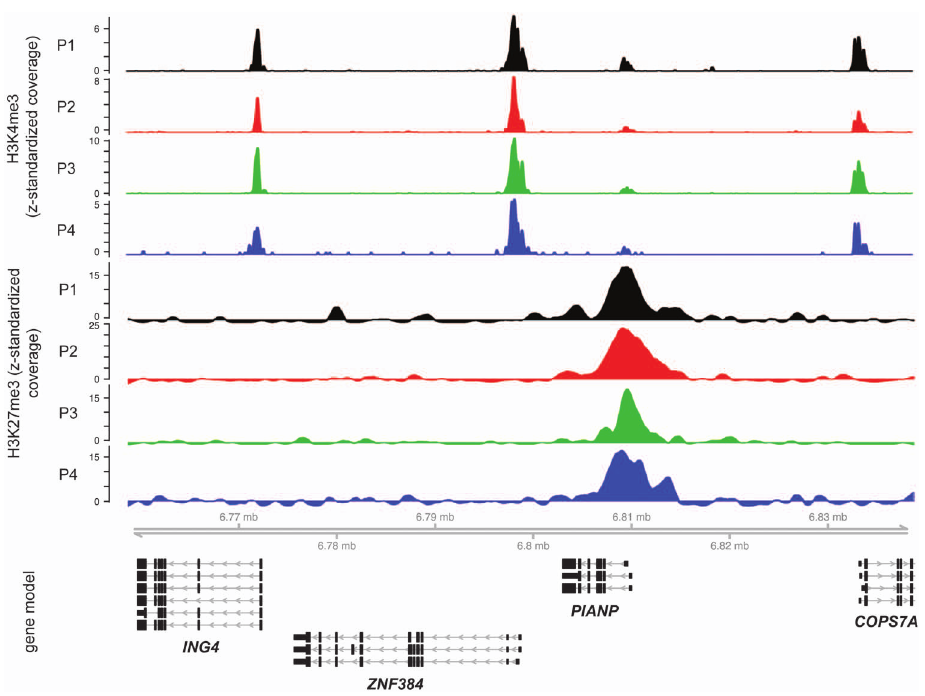
Figure 2. Genome browser snap shot of an 80 kb region on chromosome 12 of hg19. Depicted are the z-standardized ChIP-seq coverage profiles for 2 histone modifications (H3K27me3 and H3K4me3) from 4 blood donors (P1–P4). Strong H3K4me3 binding can be detected around the transcriptional start sites of the ING4 , ZNF384 and COPS7A genes. These genes are majorly devoid of H3K27me3 signals. In contrast the PIANP gene is strongly enriched for H3K27me3 but shows only weak signals for